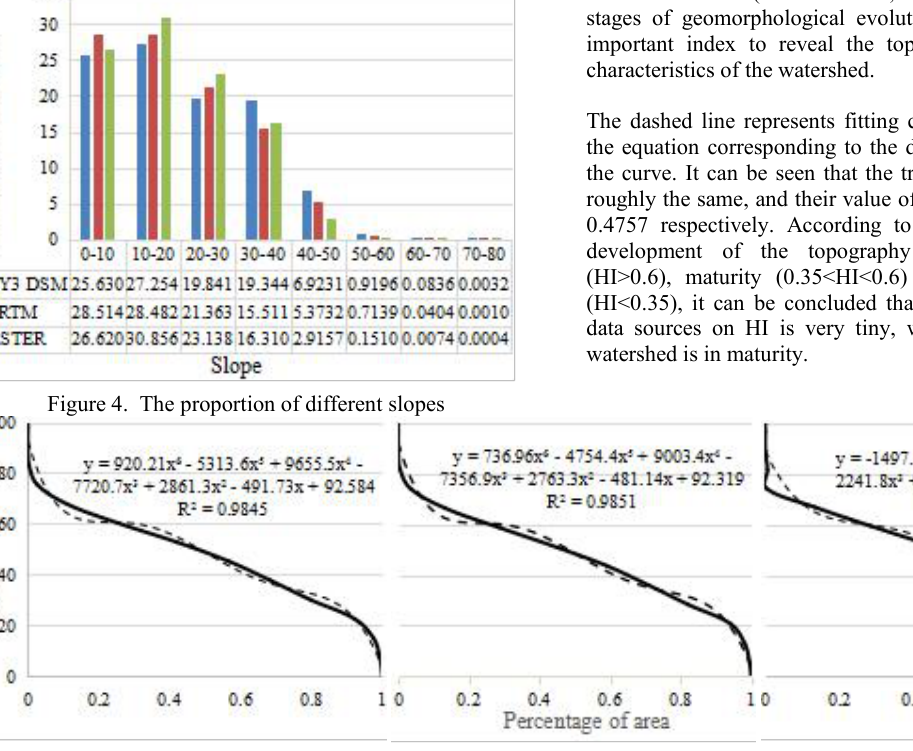
Figure 5. Elevation Distribution Curves (left: ZY3 DSM; middle:SRTM; right: ASTER)